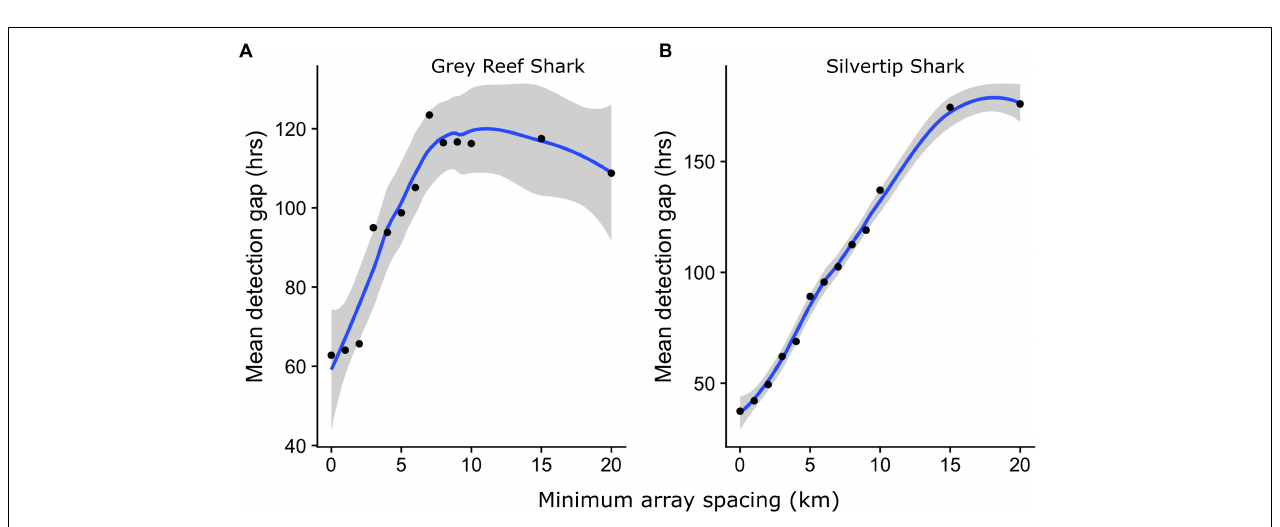
FIGURE 6 | Change (blue line: mean, shaded area: 95% confidence interval) in observed residency index (days detected per days monitored) for (A) Grey Reef Sharks and (B) Silvertip Sharks as minimum distance between receivers is increased.